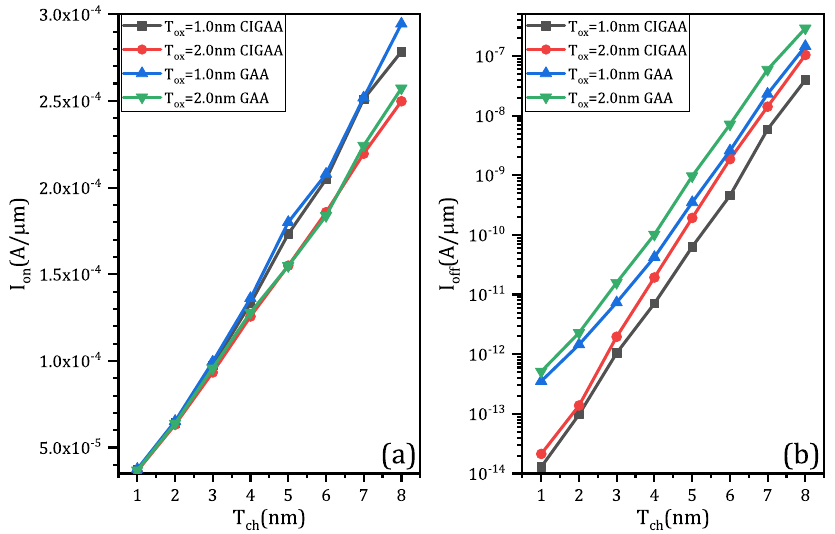
Figure 4. The simulation results of CIGAA and GAA: ( a ) on-state current (I on ) of CIGAA and GAA; ( b ) off-state current (I of f ) of CIGAA and GAA. Both of the two figures are plotted when D CI = 4.0 nm.